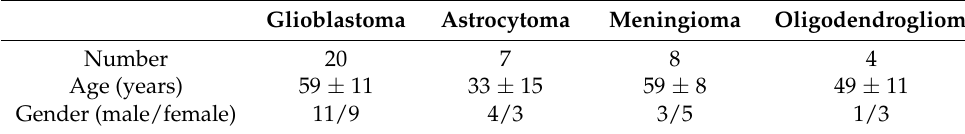
Table 1. Characteristics of the patients with brain